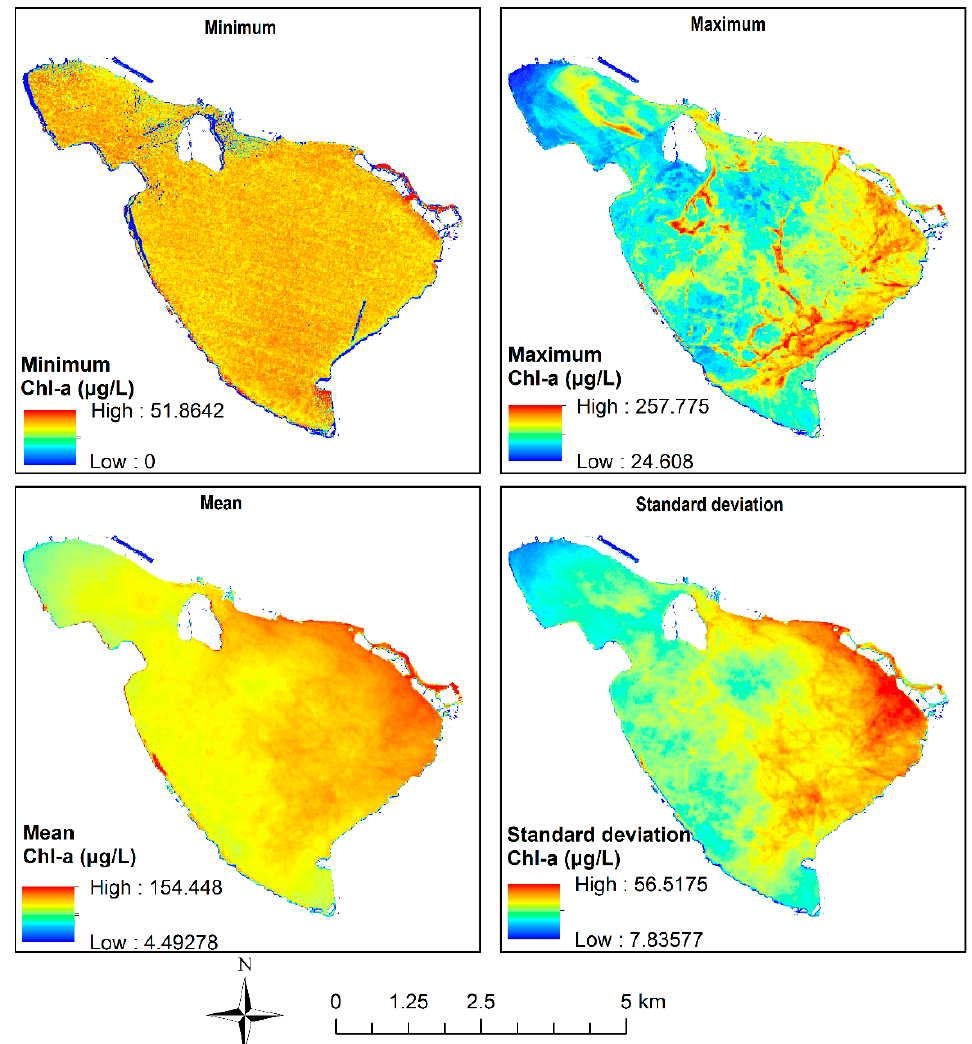
Figure 7. The maximum, minimum, mean, and standard deviations of Chl- a concentrations per pixel for the study period.